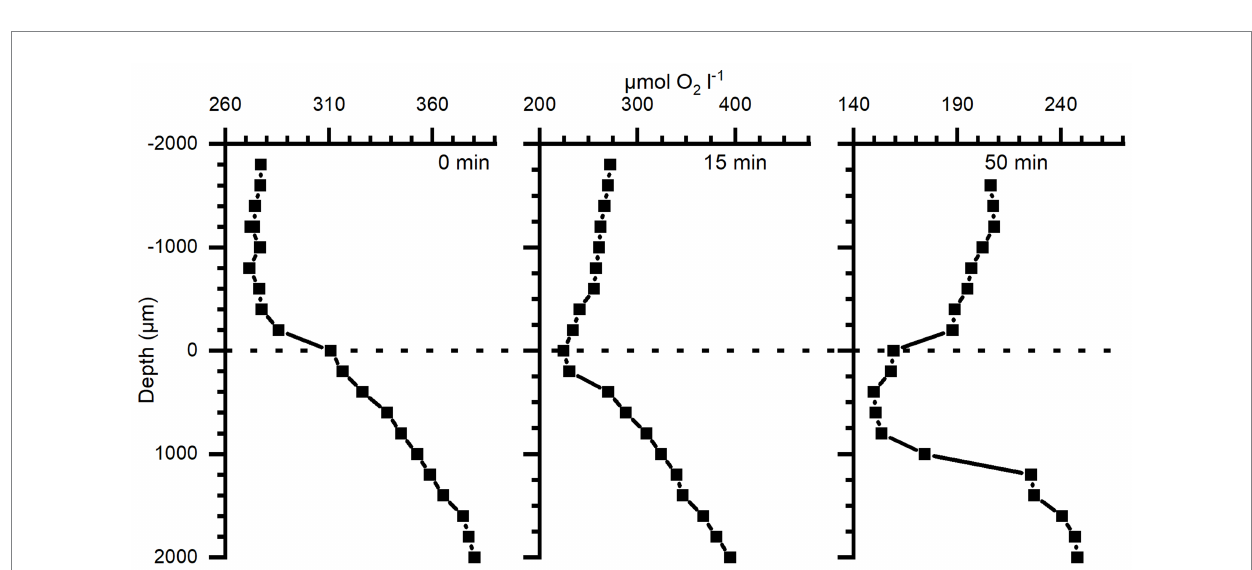
FIGURE 5 Depth profiles of O 2 concentration in bell tissue of three different Cassiopea specimens (38–67 mm Ø) incubated in darkness for 0, 15, and 50 min, respectively (38, 67, and 63 mm Ø individual, respectively), prior to measurements. Zero depth indicates the tissue-water interface, and 2,000 μ m the deepest into the tissue. Note differences in the x -axis